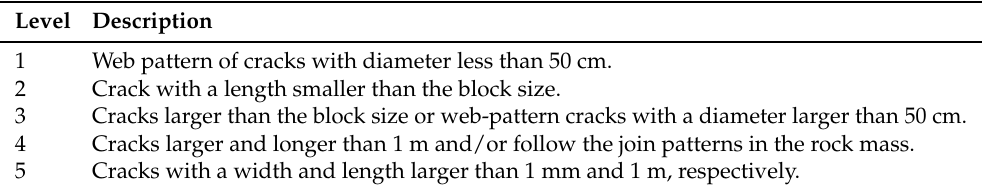
Table 1. Summary of important descriptions for the assessment of damage levels for cracks in shotcrete and concrete in interaction with rock, from guidelines by the Swedish Transport Administration